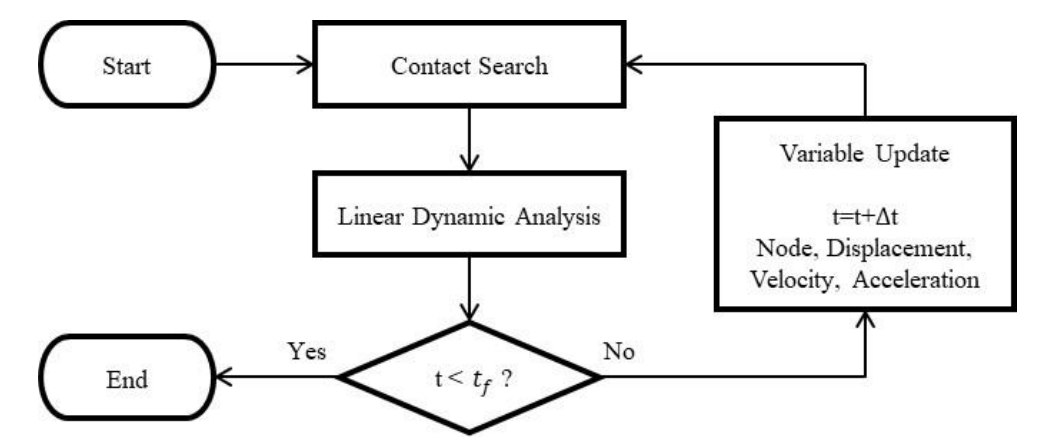
Figure 1. Flowchart for linear dynamic contact analysis.